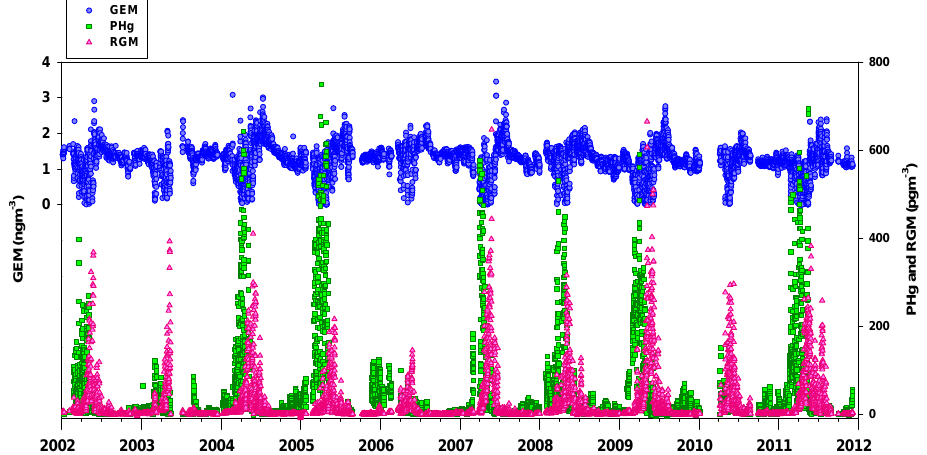
Fig. 1. Six hourly averaged data for gaseous elemental mercury (GEM-blue), particulate mercury (PHg-green) and reactive gaseous mercury (RGM-pink) from 2002 to 2011 at Alert Nunavut,